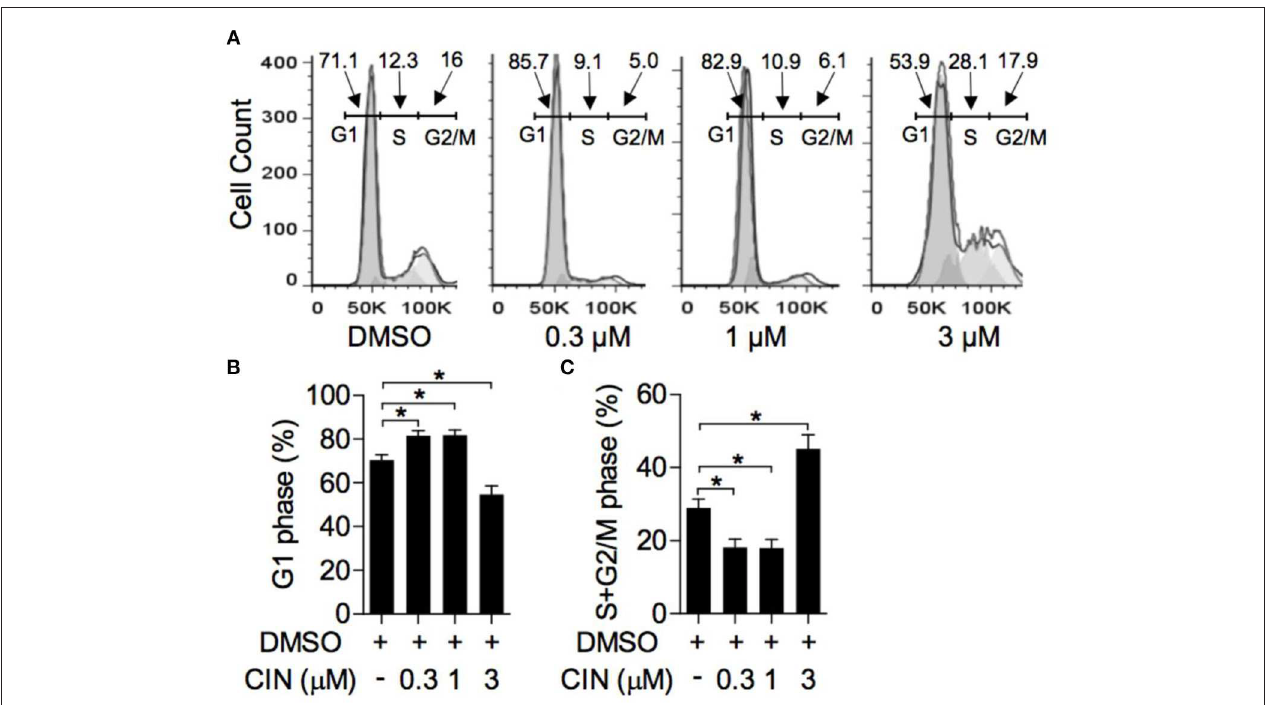
FIGURE 2 | Cinobufagin induces cell cycle arrest of OCM1. (A) OCM1 cells were treated with 0, 0.3, 1, and 3 µ M cinobufagin. After 24h, OCM1 cells were collected and stained with propidium iodide (PI). Then, the cell cycle distribution was measured with flow cytometry. The percentages of cells in the (B) G1 phase and (C) S + G2/M phase were quantified. The results are displayed as the mean ± SEM of three independent experiments [* P < 0.05, compared to OCM1 cells incubated with DMSO control].